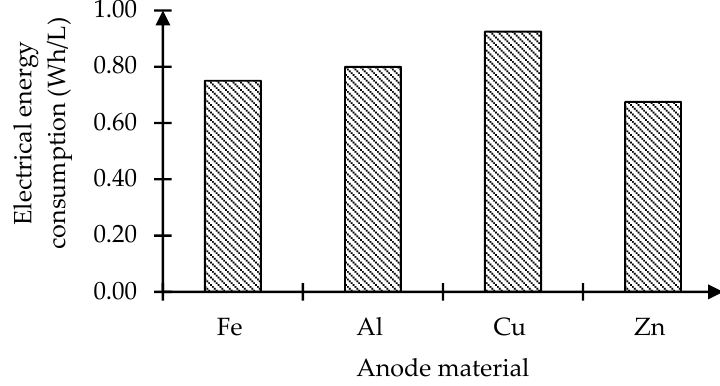
Figure 8. Electrical energy consumptions of different anode materials.